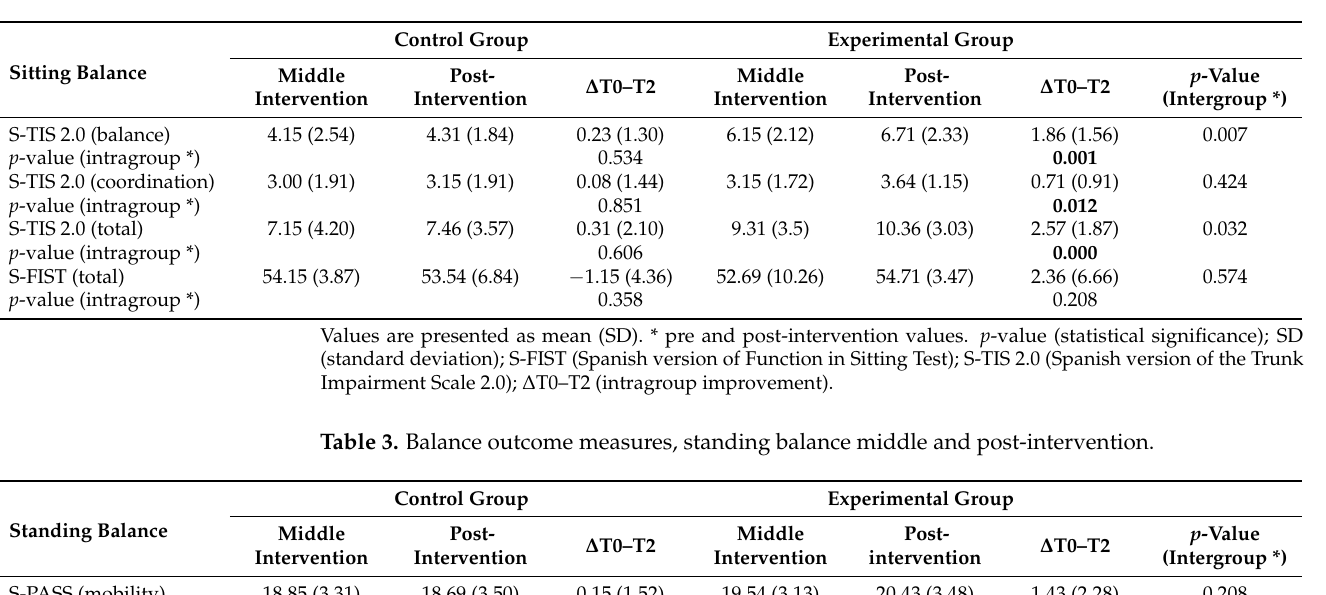
Table 2. Trunk function measures, sitting balance middle and post-intervention.